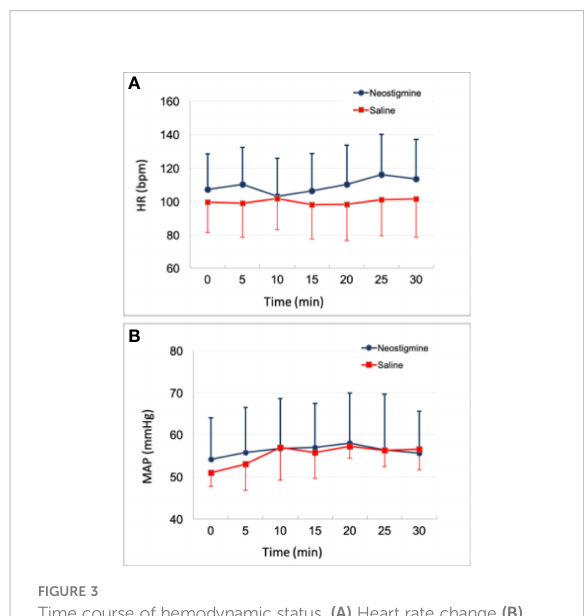
FIGURE 3 Time course of hemodynamic status. (A) Heart rate change (B) mean arterial pressure change. Either neostigmine or saline was given to each piglet at 10 min. There was no signi fi cant difference between neostigmine (n=8) and saline (n=4) in both heart rate and blood pressure (all P > 0.05). HR = heart rate; MAP = mean arterial